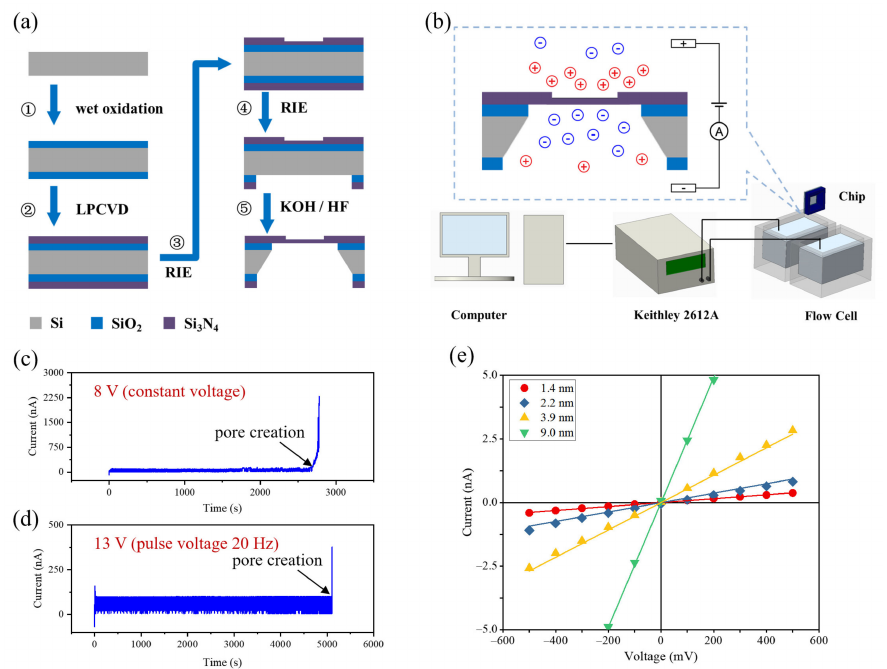
Figure 1. Schematic illustrations of ( a ) the chip fabrication process; ( b ) the nanopore fabrication setup; leakage current traces at ( c ) 8 V constant voltage and ( d ) 13 V pulse voltage on a 20 nm-thick SiN x membrane in 1 M KCl at pH 8. ( e ) I–V curves for 4 nanopores with various